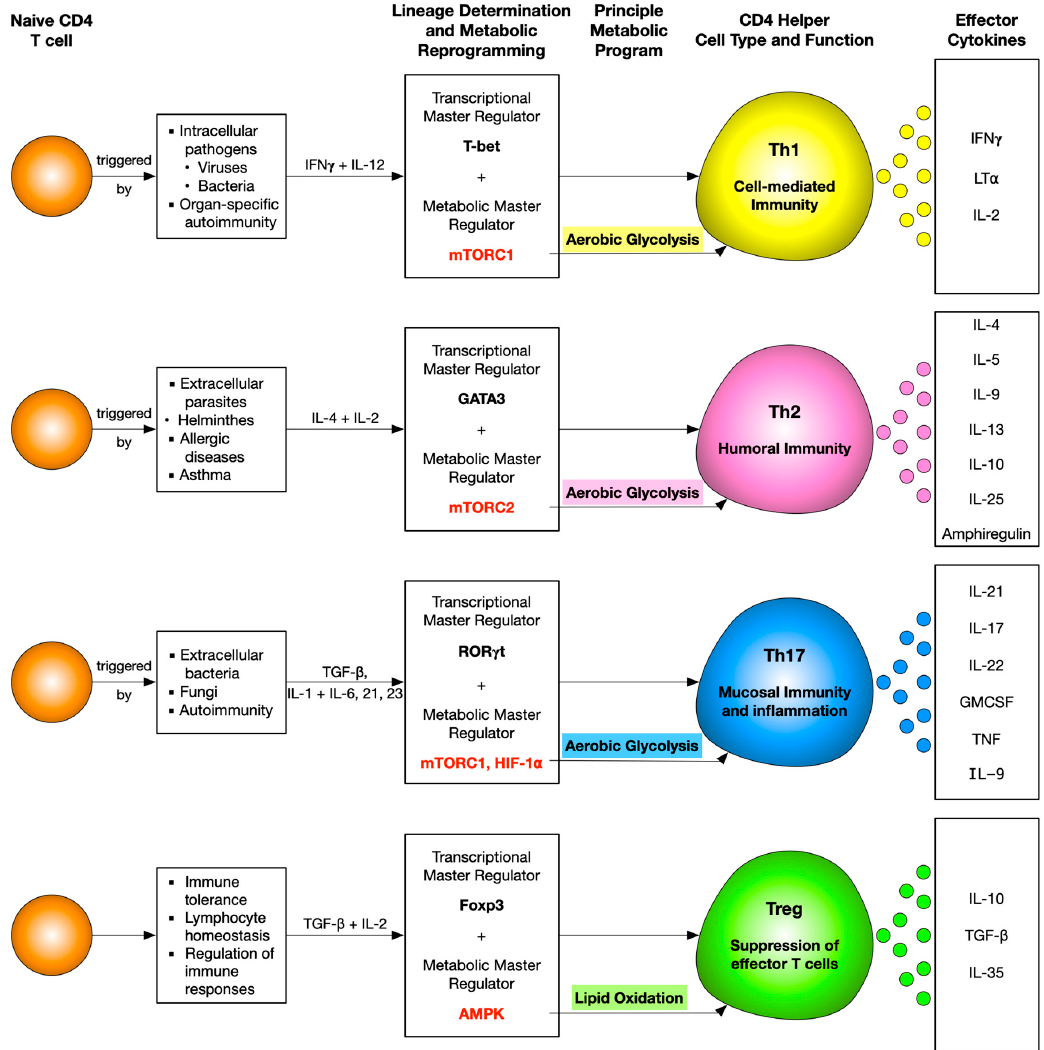
Figure 3. Snapshot of coordinated interplay between T cell differentiation and principle metabolic pathways monitoring different CD4 helper T cells. A naive CD4 T cell differentiates into different helper T cell subsets programmed by a master transcriptional regulator and predominant metabolic signaling molecule and pathway. Mammalian target of rapamycin complex 1 (mTORC1) is essential for Th1, mTORC2 for Th2, mTORC1 and HIF-1 α for Th17, and AMP-activated protein kinase (AMPK) for Treg differentiation. Despite the different molecular metabolic regulators, Th1, Th2, and Th17 adopt aerobic glycolysis as their principle pathway, and on the other hand, Tregs adopt lipid oxidation.